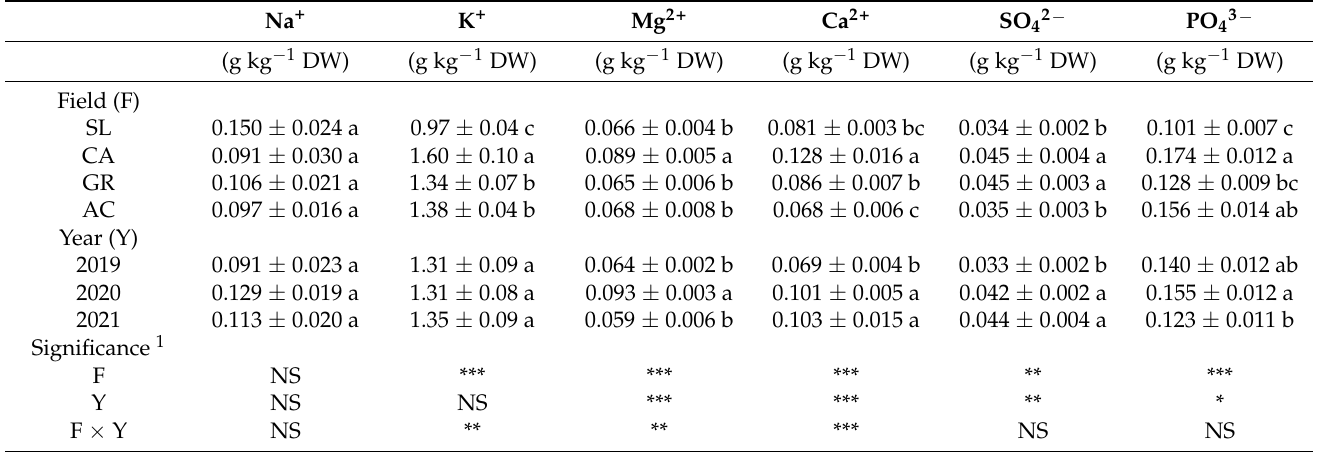
Table 2. Effects of field (F), year (Y), and their interaction (F × Y) on must minerals (Na + , K + , Mg 2+ , Ca 2+ , SO 42 − , PO 43 − ) content in V. vinifera subsp. vinifera “Falanghina” vines at the four study sites: SL-Santa Lucia, CA-Calvese, GR-Grottole, and AC-Acquafredde. Mean values and standard errors are shown. Different letters within each column indicate significant differences according to Duncan’s multiple-range test ( p ≤